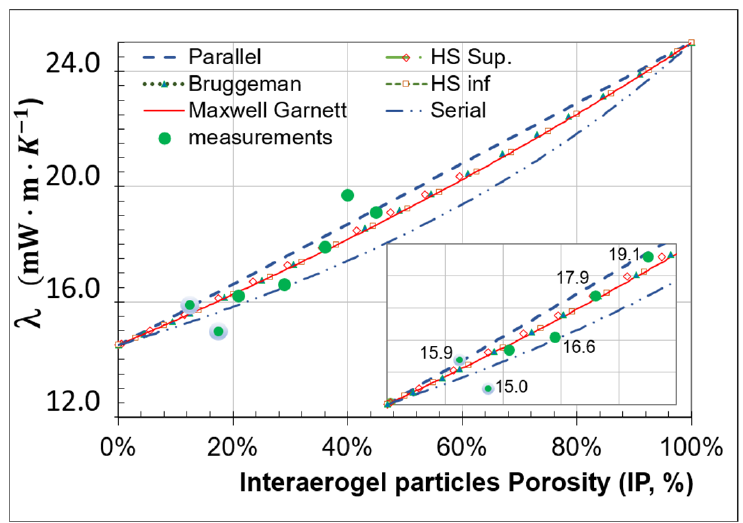
Figure 4. Homogenization simulated thermal conductivity values compared to experimental mea- surements (issued from [45]) as a function of inter-aerogel particle porosity (IP determined with X-ray tomograms). An insert zooms on data within the superinsulation range. Input values: = 14 mW · m · K − 1 , λ ∗ = 25 mW · m · K − 1 . λ ∗ SAP air